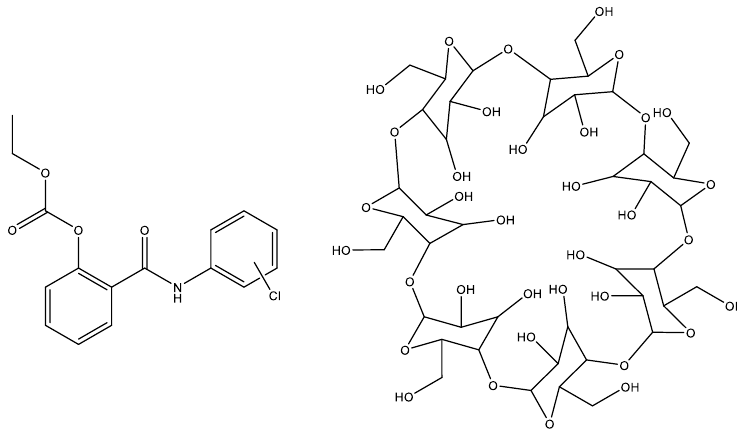
Figure 1. XRD spectra of β -cyclodextrin, ethyl ester, inclusion complex, physical mixture: ( a ) ethyl 2-(2-((2-chlorophenyl)carbamoyl)phenoxy)acetate series; ( b ) ethyl 2-(2-((4-chlorophenyl) carbamoyl)phenoxy)acetate series.